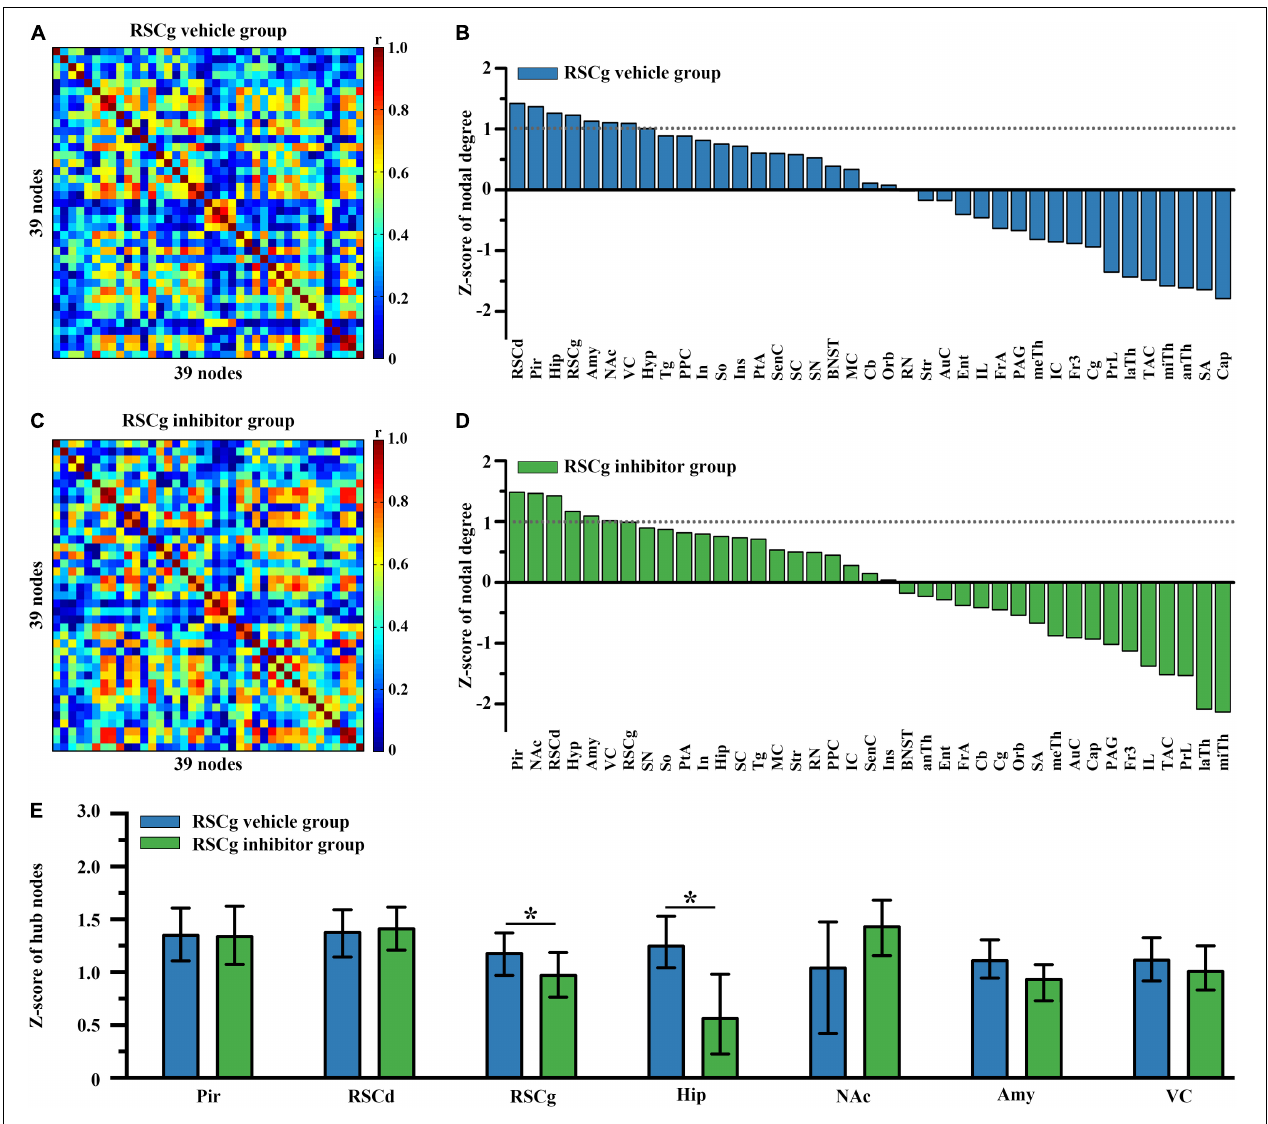
FIGURE 3 | Effects of suppressed RSCg on hub nodes of the brain-wide metabolic network during CFC. Brain-wide metabolic network of (A) RSCg vehicle group and (C) inhibitor group during CFC. Distribution of nodal degree Z -scores in network of (B) RSCg vehicle and (D) inhibitor group. (E) Decrease in nodal degree of RSCg and hippocampus in rats with suppressed RSCg. The error bar indicates the 95% confidence intervals obtained from 1,000-iteration bootstrapping procedures. RSCg vehicle group n = 35, RSCg inhibitor group n = 32. * p < 0.05, permutation